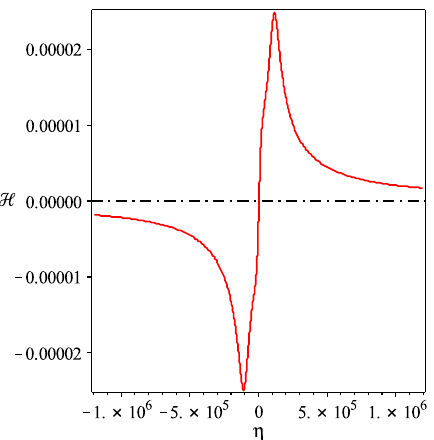
Fig. 2 The evolution of the conformal Hubble parameter H versus η . At bounce point ( η = 0 ; H = 0), it shows a transition from a contracting universe to an expanding one from left to right The evolution of the EoS parameter has been shown in Fig. 3 (red dash line). As one can see, in the (cid:3) CDM epoch, w is